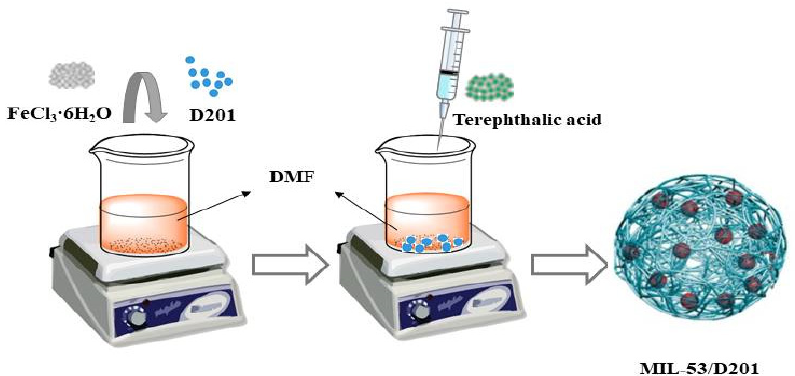
Figure 2. Schematic illustration of preparation process of MIL-53/D201 composite material.